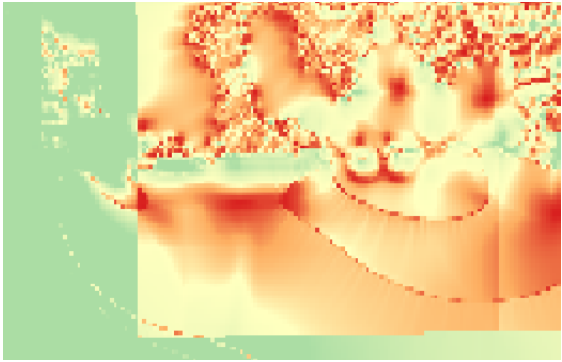
Figure 13. Example for Deviations by NoData.